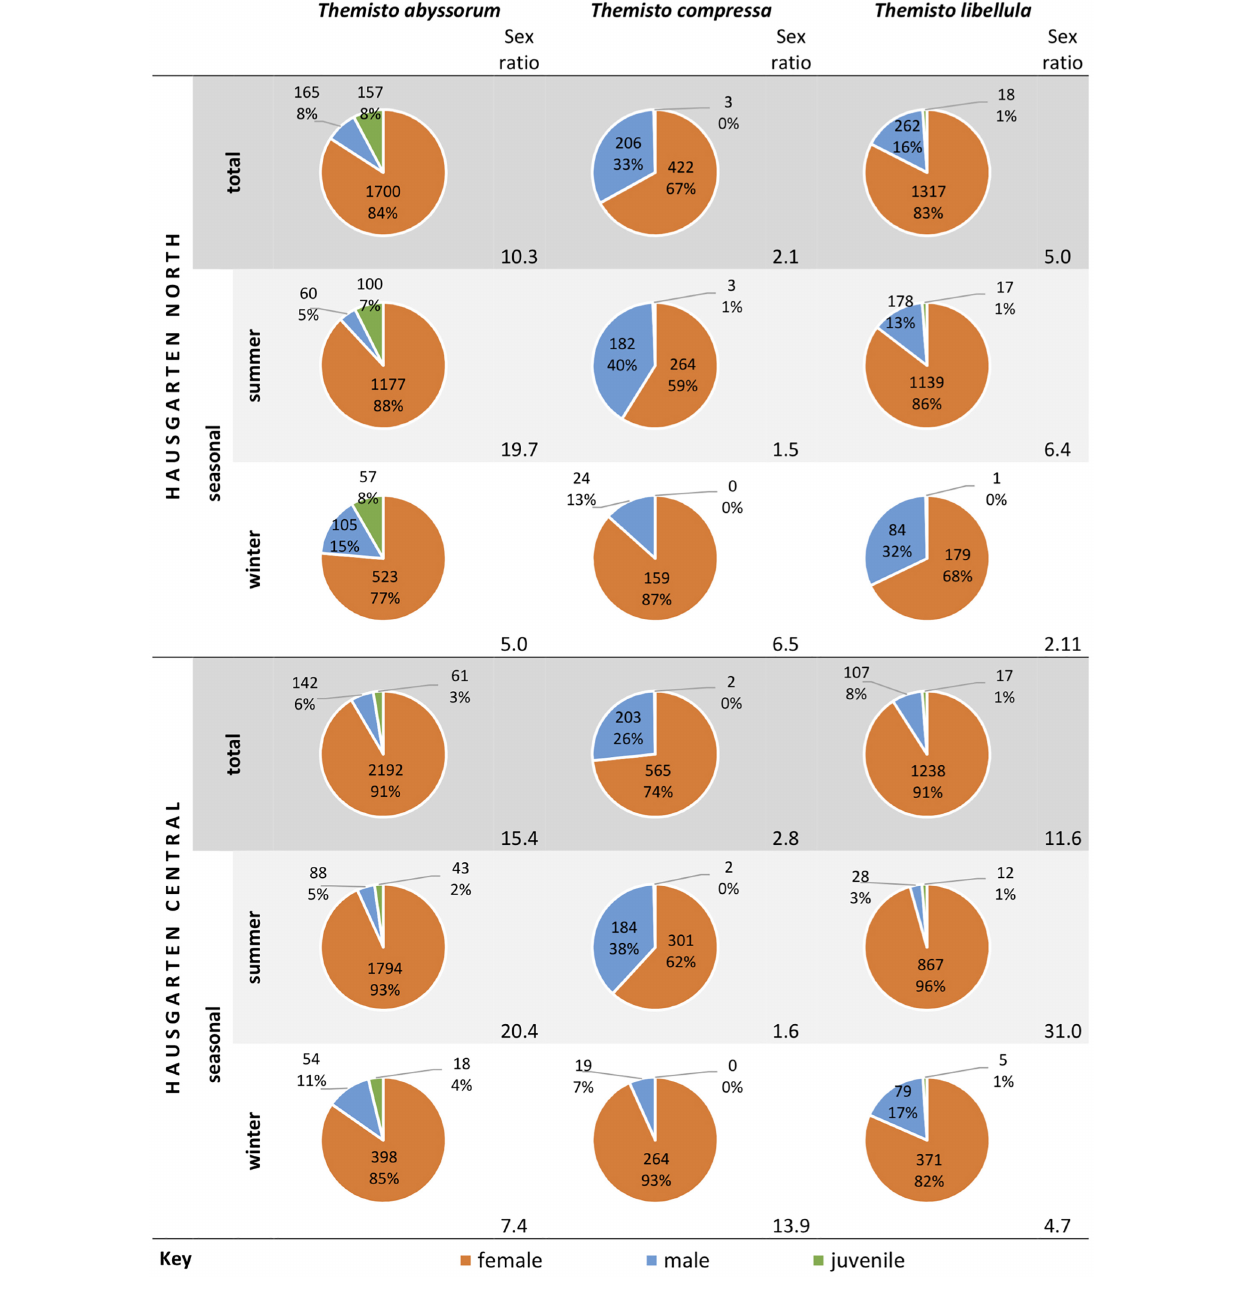
FIGURE 4 | Total and seasonal percentages of gender and maturity of the Themisto species between 2011 and 2014; absolute numbers are counts, relative numbers are proportions of total counts. Sex ratios = female counts/male counts. Missing data were replaced with comparative means of the respective